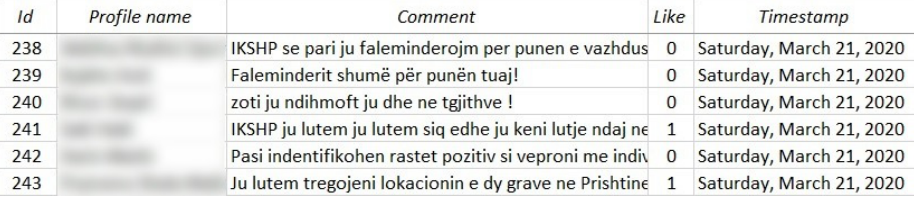
Figure 2. Dataset 1.0—Unlabeled comments.